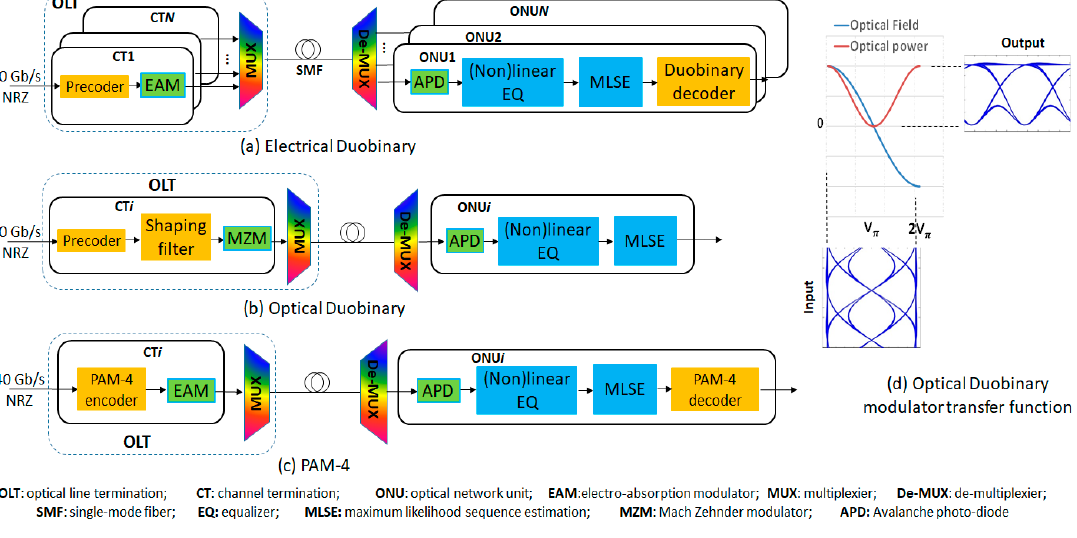
Figure 2. Schematic architectures of 40 Gb/s lane rate NG-PON downstream links with ( a ) electrical Duobinary; ( b ) optical Duobinary; and ( c ) PAM-4 formats; ( d ) the optical Duobinary modulator transfer function where the Mach-Zehnder modulator (MZM) is biased at the null point, and the eye-diagrams correspond to the electrical driving signal, and the output optical intensity signal.